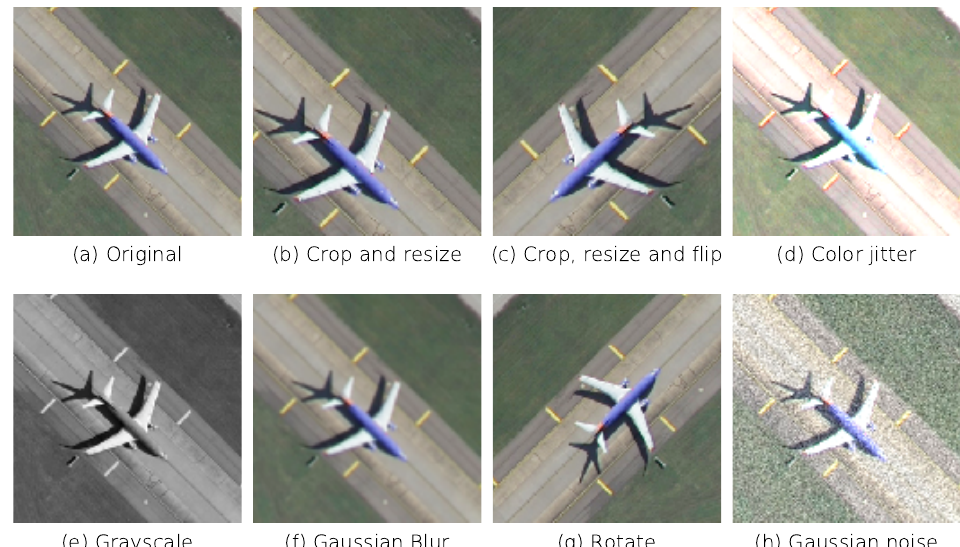
Figure 2. We show data augmentation operators through a series of illustrations. Note that some augmentation technologies have a few internal parameters that need to be chosen randomly, such as Gaussian blur and